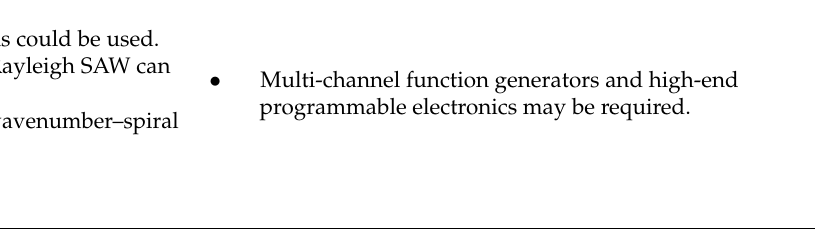
Table 1. Comparison of the various type interdigital (IDT) of surface acoustic wave (SAW). Images reproduced with permission from references [23,26,31,39,40,102,103]. IDT Structure/Type